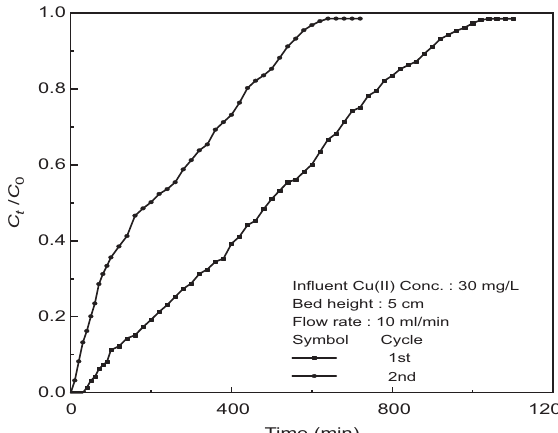
Figure 11. Regeneration plot with experimental data for the adsorption of Cu(II) on coconut shell